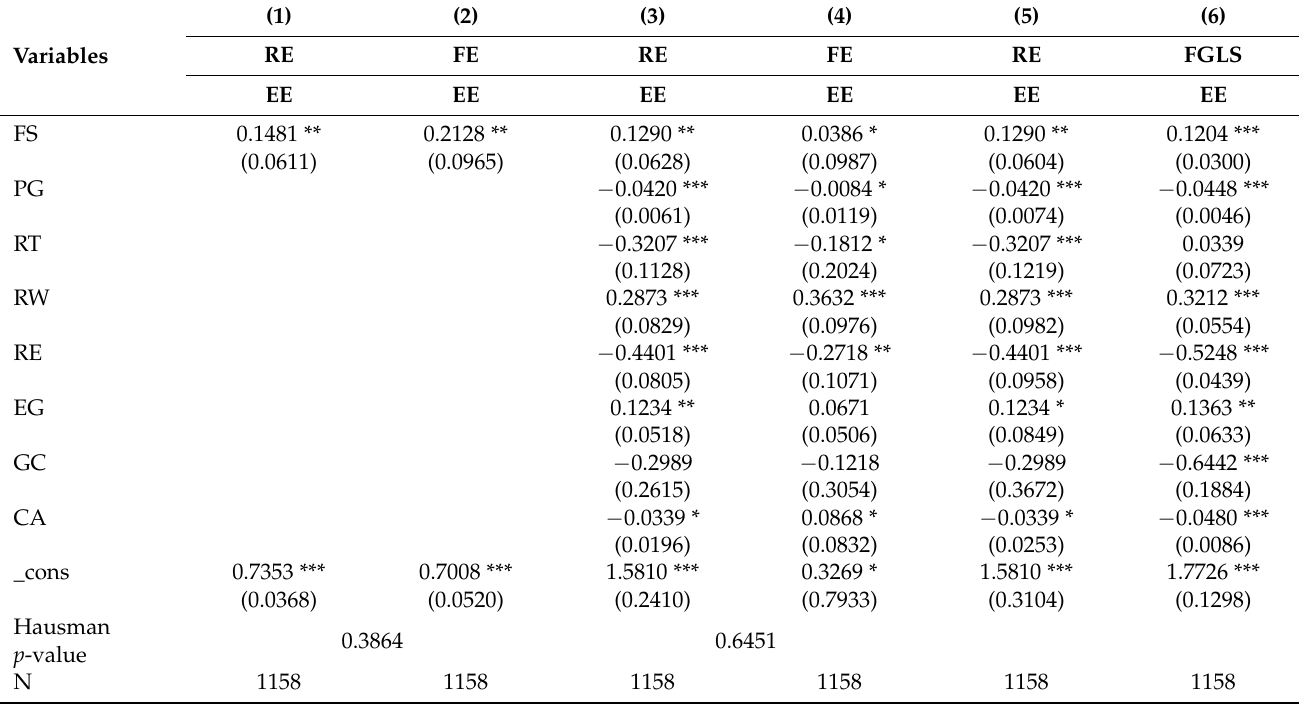
Table 3. The baseline regression on the impact of fiscal stress on environmental